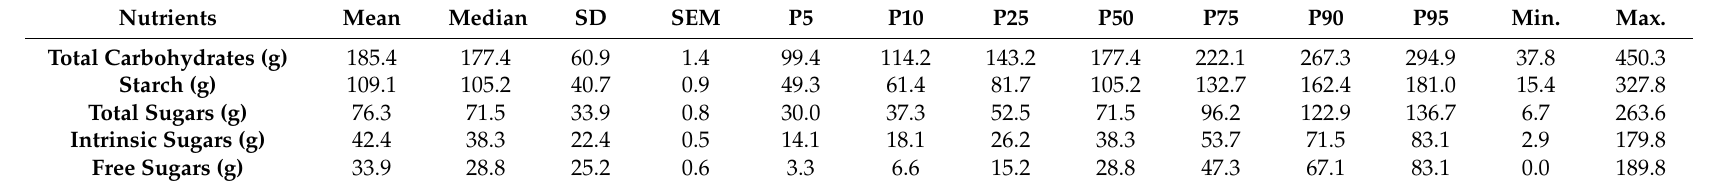
Table 1. Carbohydrates intake and percentiles (P) distribution (g/day) in the Spanish ANIBES Study population (9 to 75 years old).